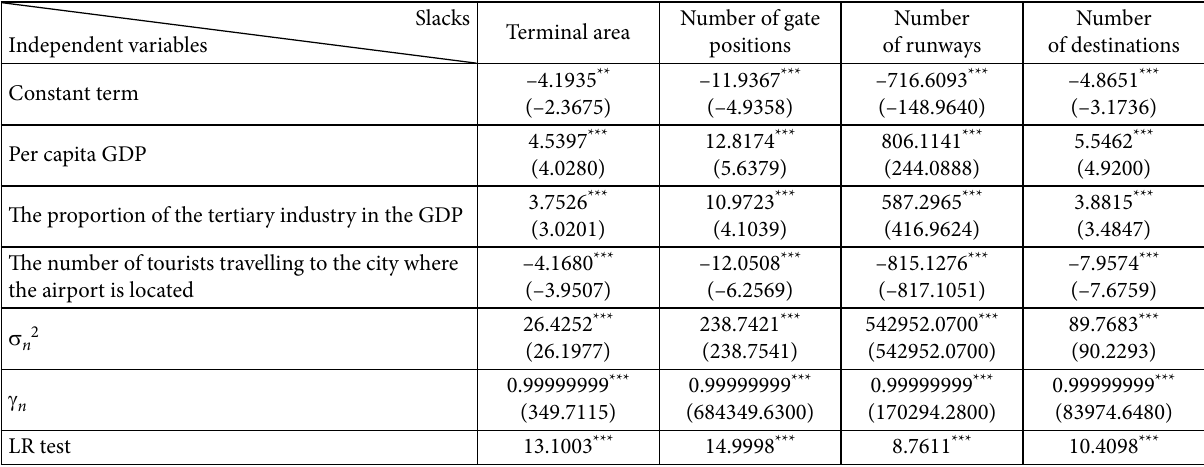
Table B.3. SFA estimation results in 2015